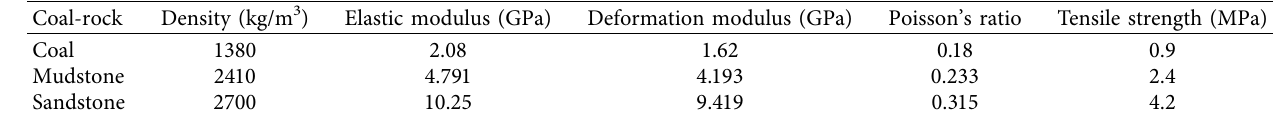
Figure 2: Mechanical model diagram of numerical calculation. Table 1: Mechanical parameters of mining seam.